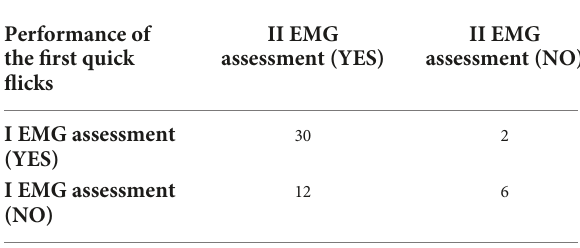
TABLE 4 Sample contingency table, showing the distribution of the first quick flick performance in the first and second